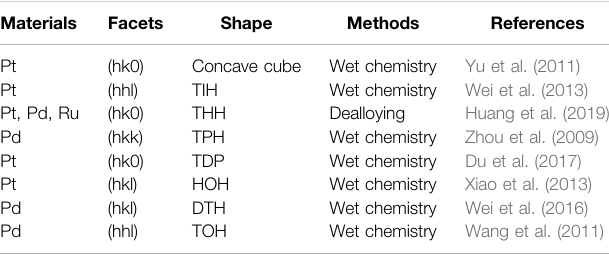
TABLE1| Selectedsummaryofsyntheticprotocolsofnanocrystalswithlowindex and high index crystallographic